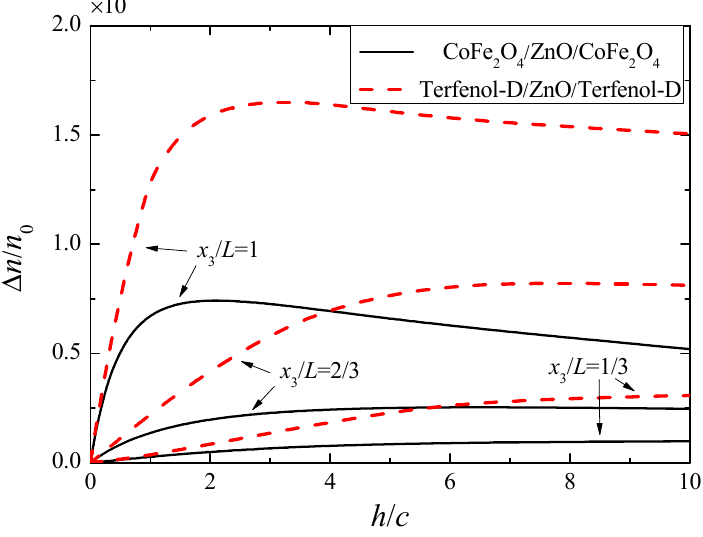
Figure 9. ∆ n / n 0 versus h / c at di ff erent locations along the n n Δ versus h/c at different locations along the rod. Figure 9. 0